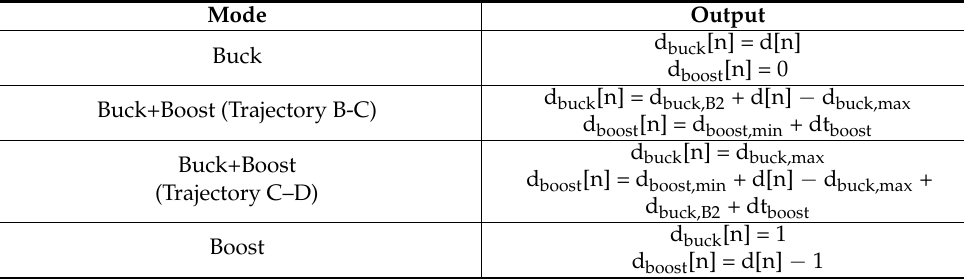
Figure 14. State machine including the hysteresis (h) and the correction of the dead times (dt boost is the dead time used in M3/M4 pair). the dead time used in M3/M4 pair). Table 5. Definition of (d buck [n],d boost [n]) pairs.